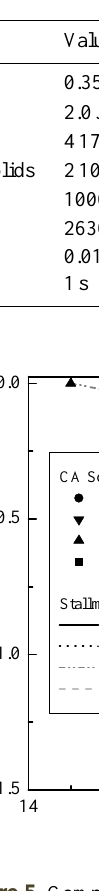
Figure 5. Comparison between the analytical (Stallman, 1965) and coupled CA model steady state solutions for conductive and convec- tive heat transfer. The soil column in this example is infinitely long, initially at 20 ◦ C, and the upper surface is subjected to a sinusoidal temperature with amplitude of 5 ◦ C and period of